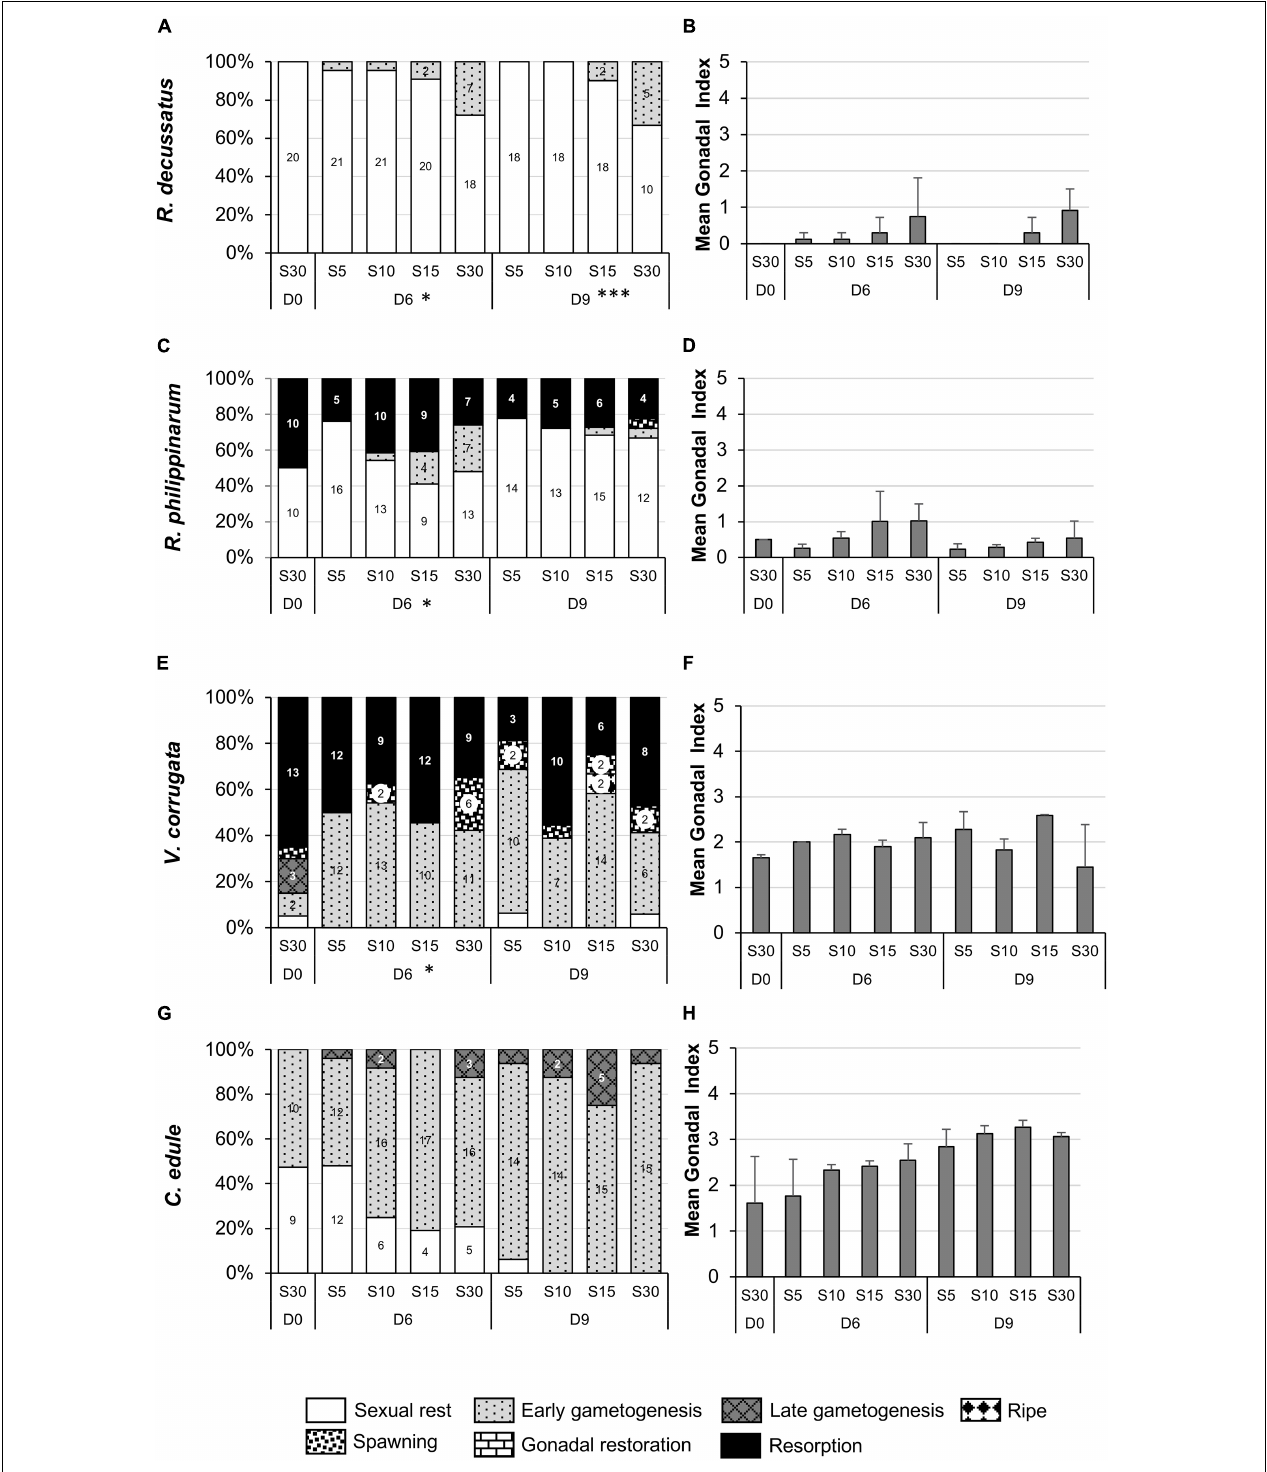
FIGURE 4 | Gonadal stages (percentage) (A,C,E,G) and gonadal index (mean + SD) (B,D,F,H) in the December low salinity experiment in each salinity treatment at the beginning of the experiment (D0), after six days of stress (D6) and after three days of recovery (D9). Salinity treatments: S5 corresponds to a salinity ramp from 5 to 20, S10 from 10 to 25, S15 from 15 to 30, and S30 control. (A,B) Ruditapes decussatus . (C,D) Ruditapes philippinarum . (E,F) Venerupis corrugata . (G,H) Cerastoderma edule . Asterisks refer to the significance of the multinomial logistic regressions: ∗ p < 0.05; ∗∗∗ p < 0.001. Number in the bars indicate number of individual clams within categories. Categories without number but present in the graph means one individual.